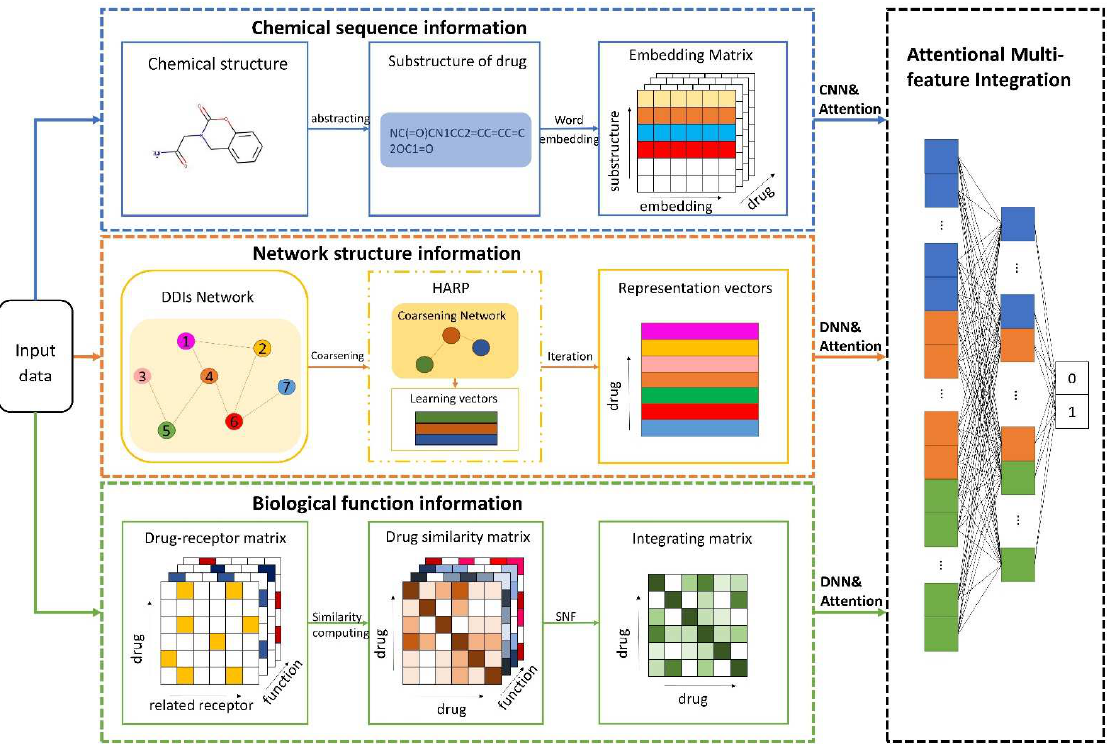
Figure 1. The pipeline of BioChemDDI. After inputting data, the sub-model of chemical sequence information obtains an embedding matrix of each drug that can be reduced as a 1-dimension vector by the CNN. The network structural information is learned by the method of HARP, and the feature vector can be further screened for the characteristic factors through the hidden layers. Multiple biological function matrices are used to generate multiple drug similarity matrices, which can be fused by SNF and further screened for characteristic factors by the hidden layers. The module of feature integration with attention contains three hidden layers that finish the final DDI prediction.